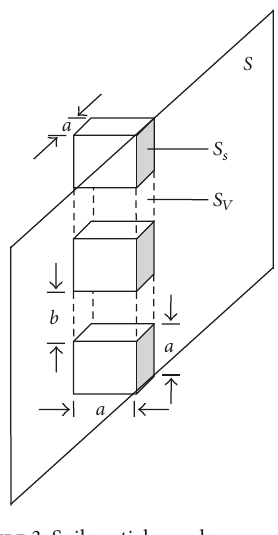
Figure 3: Soil particles and pores